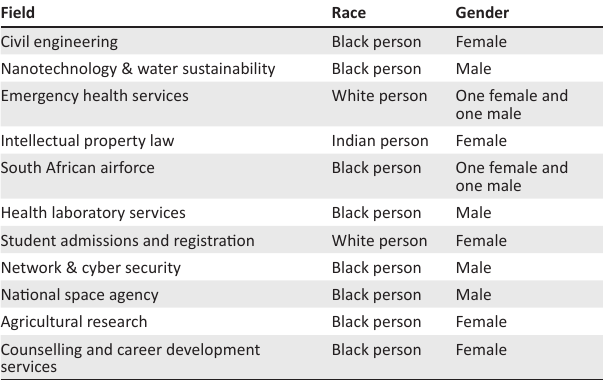
TABLE 1: Demographics of speakers from different science, technology, engineering, and mathematics